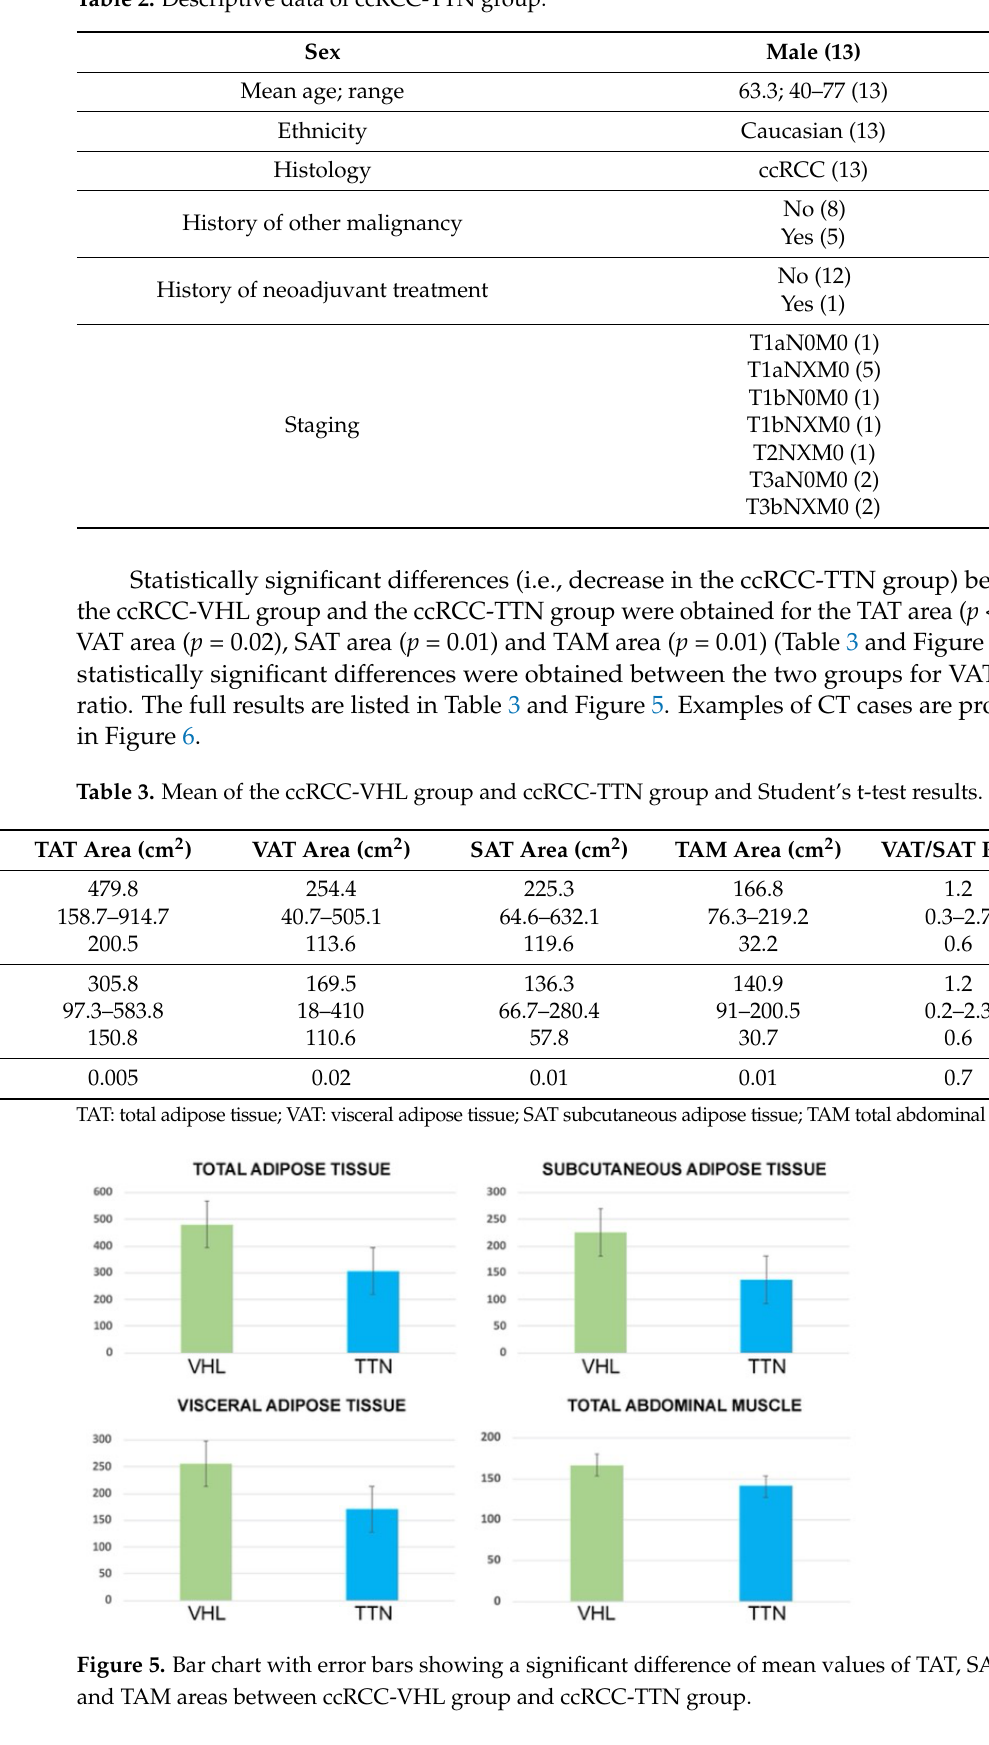
. Figure 6. Axial CT images showing VAT segmented in orange, TAM segmented in pink salmon and SAT segmented in yellow in ccRCC-VHL patient ( A ) and ccRCC-TTN patient ( B ), clearly showing the decreased amount of VAT, TAM and SAT in the ccRCC-TTN patient. Please note that this is a